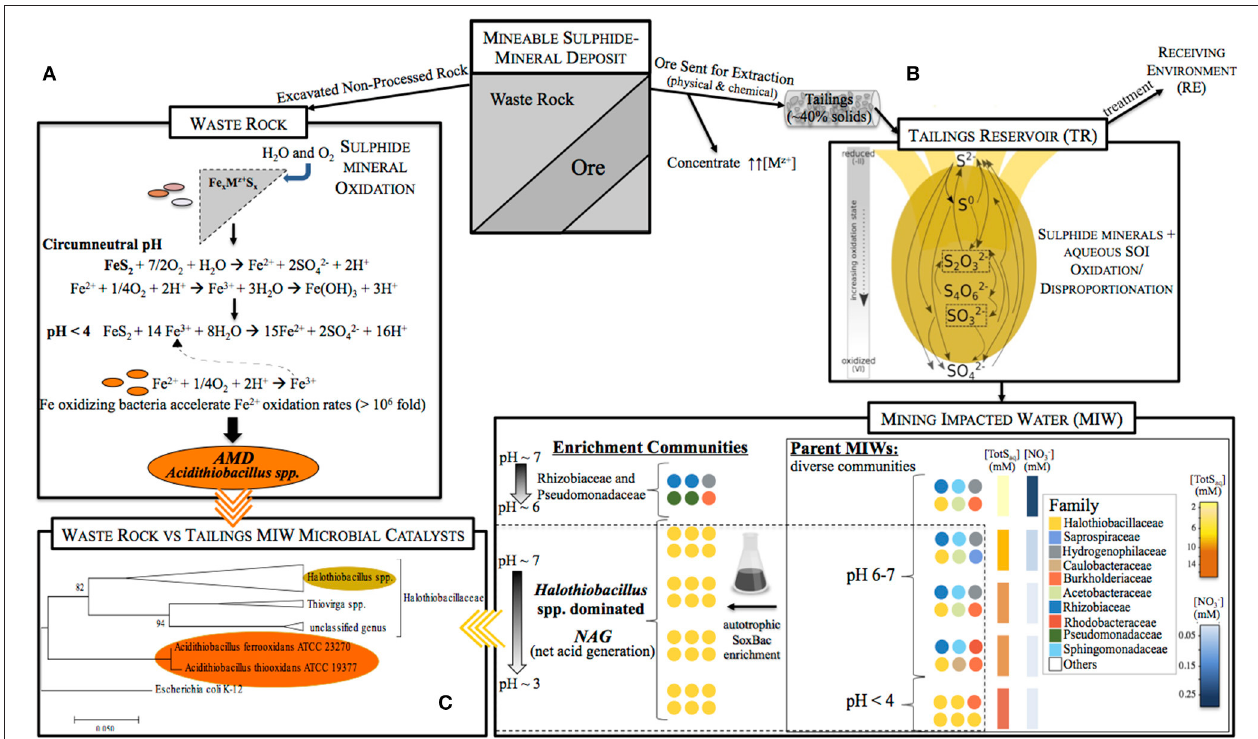
FIGURE 5 | Mining of FeS x minerals creates sulfide rich waste rock (A) , as well as post extraction sulfide rich tailings managed in tailings reservoirs (B) . Results of this study show that the sulfur geochemical reactions that occur, as well as the important microbial players associated with either AMD (A) or NAG (B) conditions in these two contexts differ. Waste rock contexts are dominated by Fe and S oxidizing acidophiles associated with the iron and sulfur rich minerals hosted in these materials (A) . In contrast, tailings reservoirs exhibit far greater geochemical diversity and sulfur compound complexity (B) . Results here identify that parent microbial communities differ across tailings reservoir MIW samples consistent with variable geochemistry (B) . However, SoxBac enrichments experiments identify the genus Halothiobacillus spp. as an important driver of NAG generation that appears widespread within these tailings reservoir MIWs. (C) Phylogenetic relationship/distance between Halothiobacillus spp. and Acidothiobacillus ferridoxans (a well-known organism associated with AMD conditions) indicate that these are not closely related organisms indicating that AMD based understanding of microbial sulfur cycling will not accurately reflect NAG generation within tailings